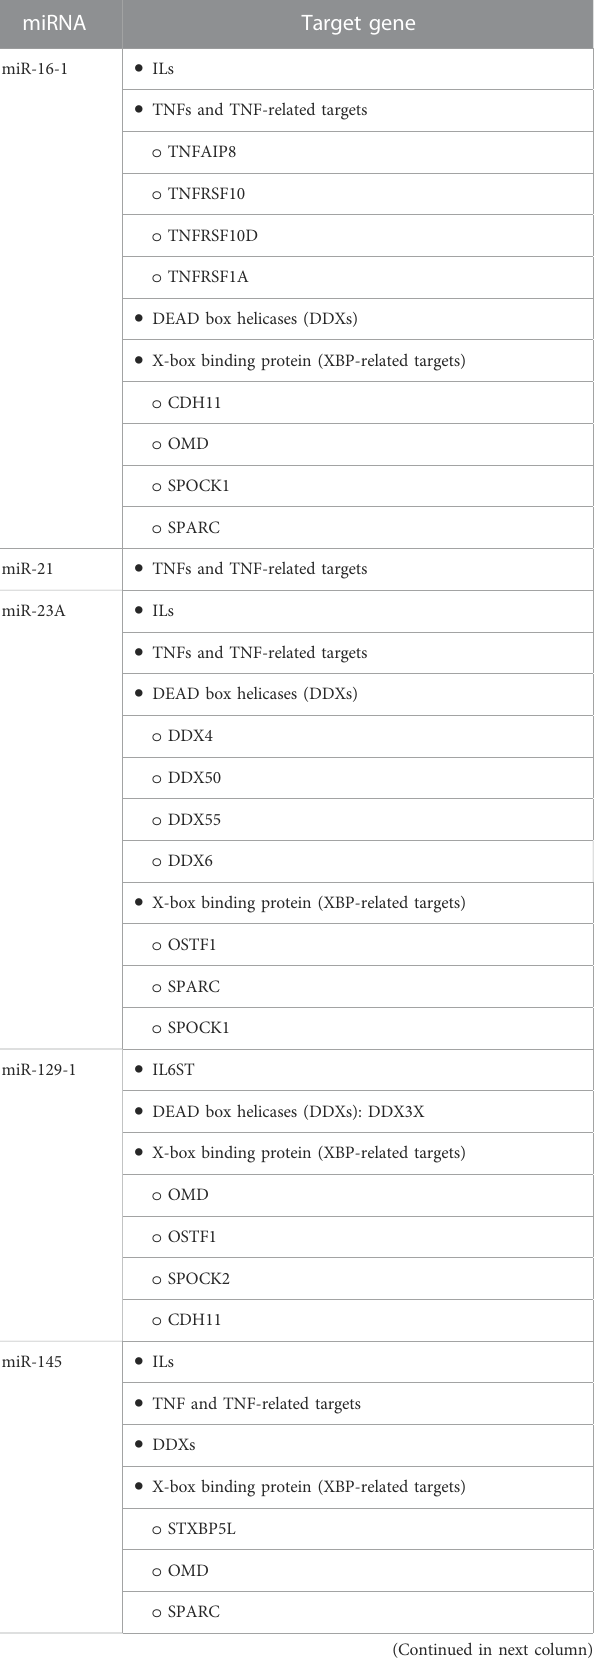
TABLE 3 The most upregulated miRNAs and their predicted targets (Musolino et al., 2018). miRNA Target gene